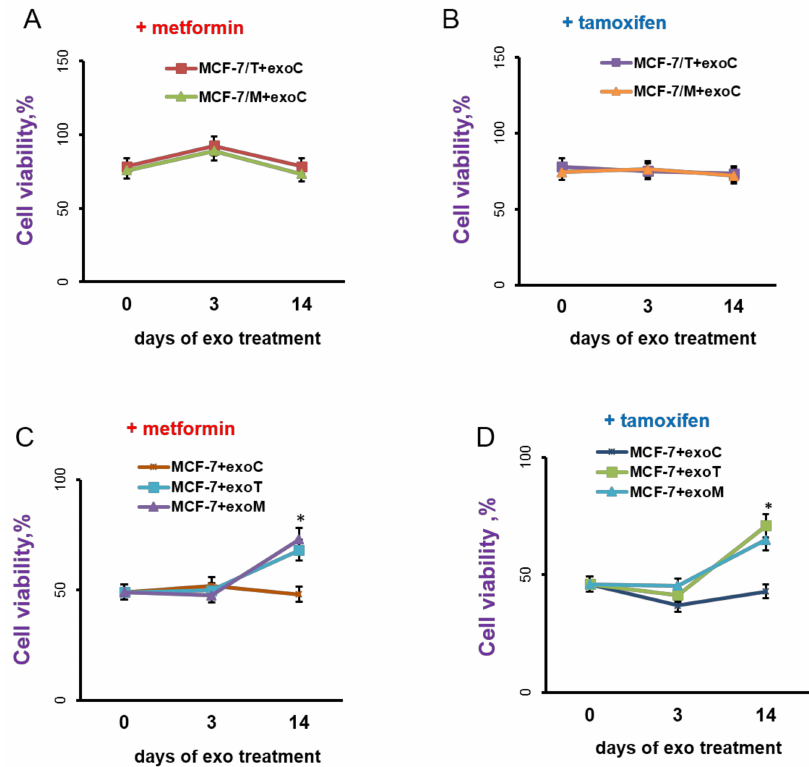
Figure 5. Exosomes influence on the cell response to metformin and tamoxifen. ( A , B ) The resistant MCF-7/T and MCF-7/M cells were cultured without exosomes or in the presence of the control exosomes from MCF-7 cells for 3 or 14 days, then the cells were treated with 5 µ M tamoxifen or 10 mM metformin for 3 days and the amount of the viable cells was counted by the MTT-test. ( C , D ) The MCF-7 cells were cultured in the presence of the exosomes from MCF-7, MCF-7/T or MCF-7/M cells for 3 or 14 days, then the cell response to metformin and tamoxifen was determined as described above. Data represent mean value ± S.D. of three independent experiments. Cell viability (%) was expressed as a percentage relative to cells treated with vehicle control. * p < 0.05 versus MCF-7 +